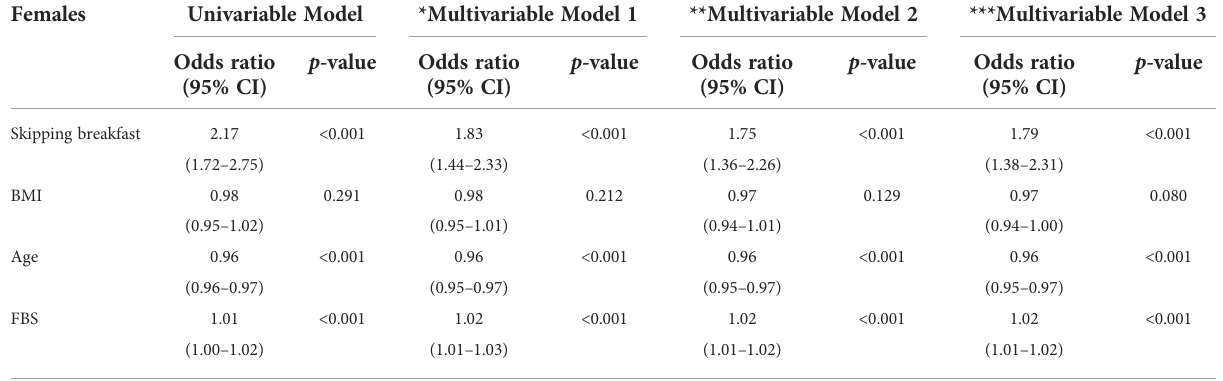
TABLE 2B Logistic regression analysis for the prevalence of proteinuria above 1+ in